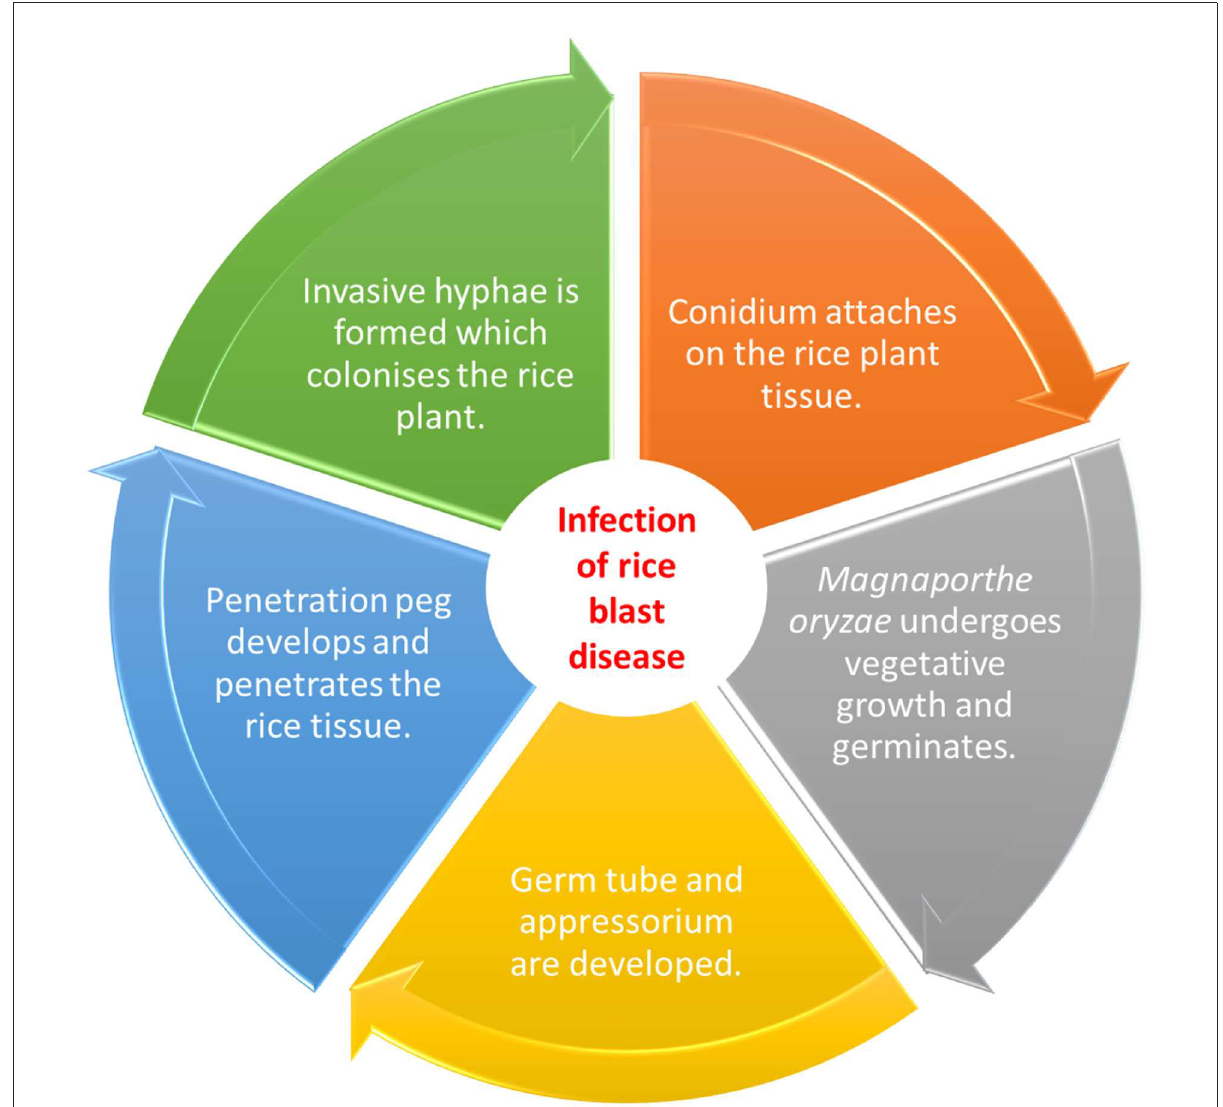
FIGURE1 Invasion of Magnaporthe oryzae into rice plant, causing rice blast disease. The chart was illustrated based on the information obtained from Mentlak et al. (2012).